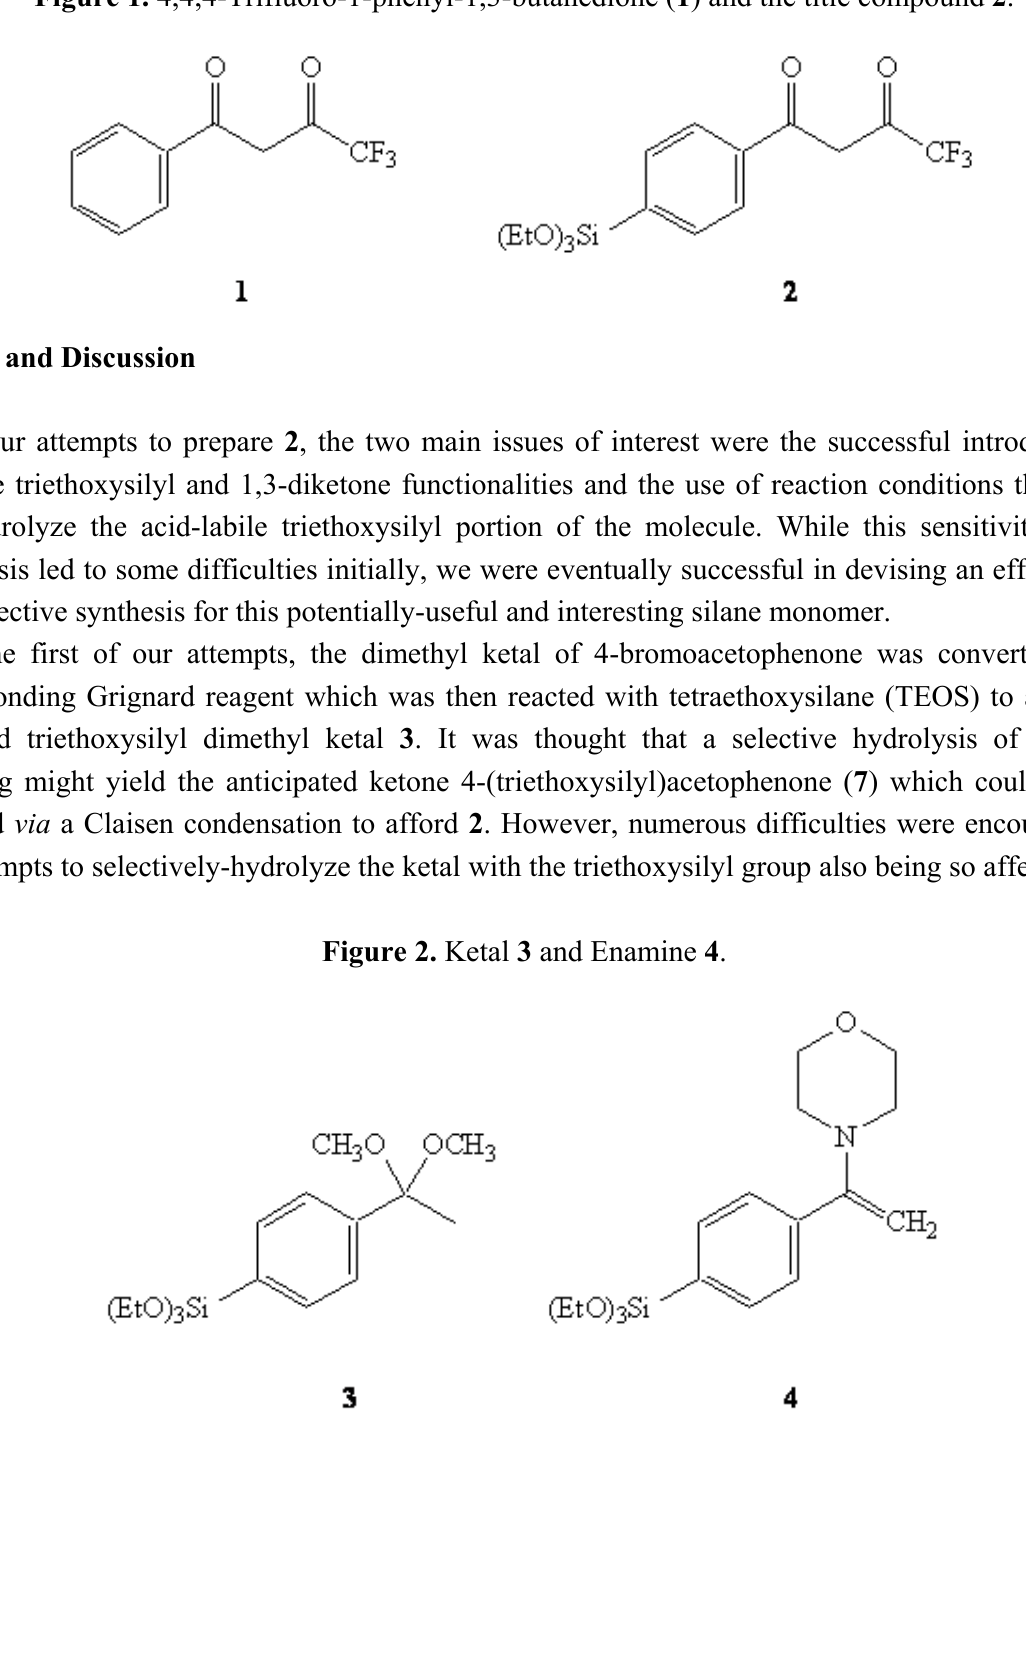
Figure 1. 4,4,4-Trifluoro-1-phenyl-1,3-butanedione ( 1 ) and the title compound 2 .